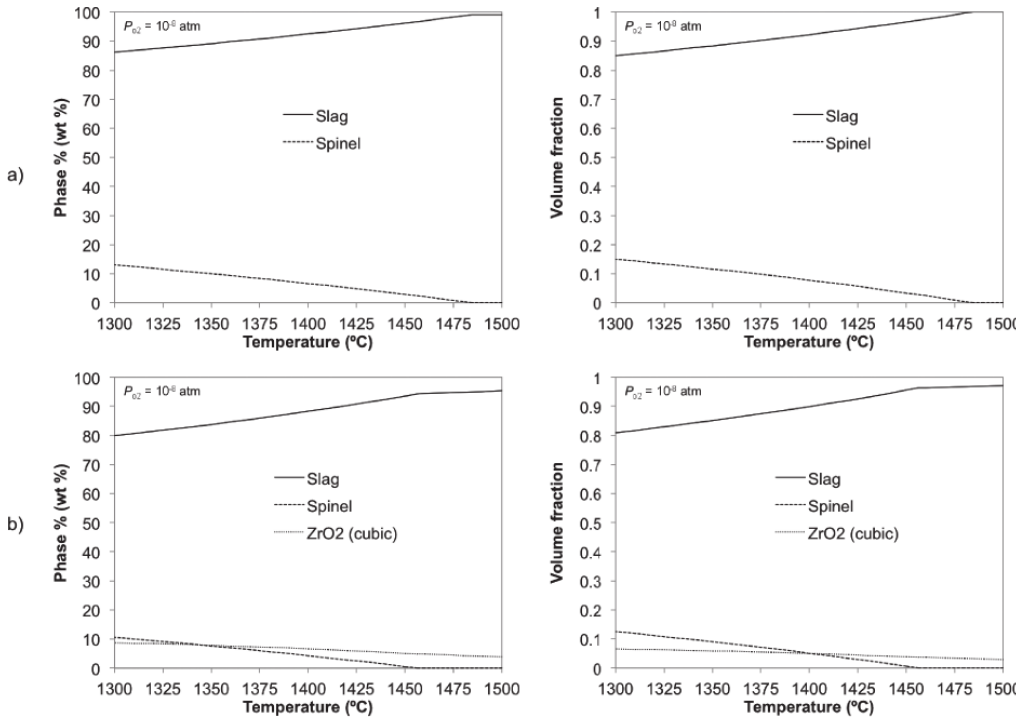
Fig. 5: Phase percentage vs. temperature (a) without ZrO 2 (b) with ZrO 2 at P o 2 = 10 − 8